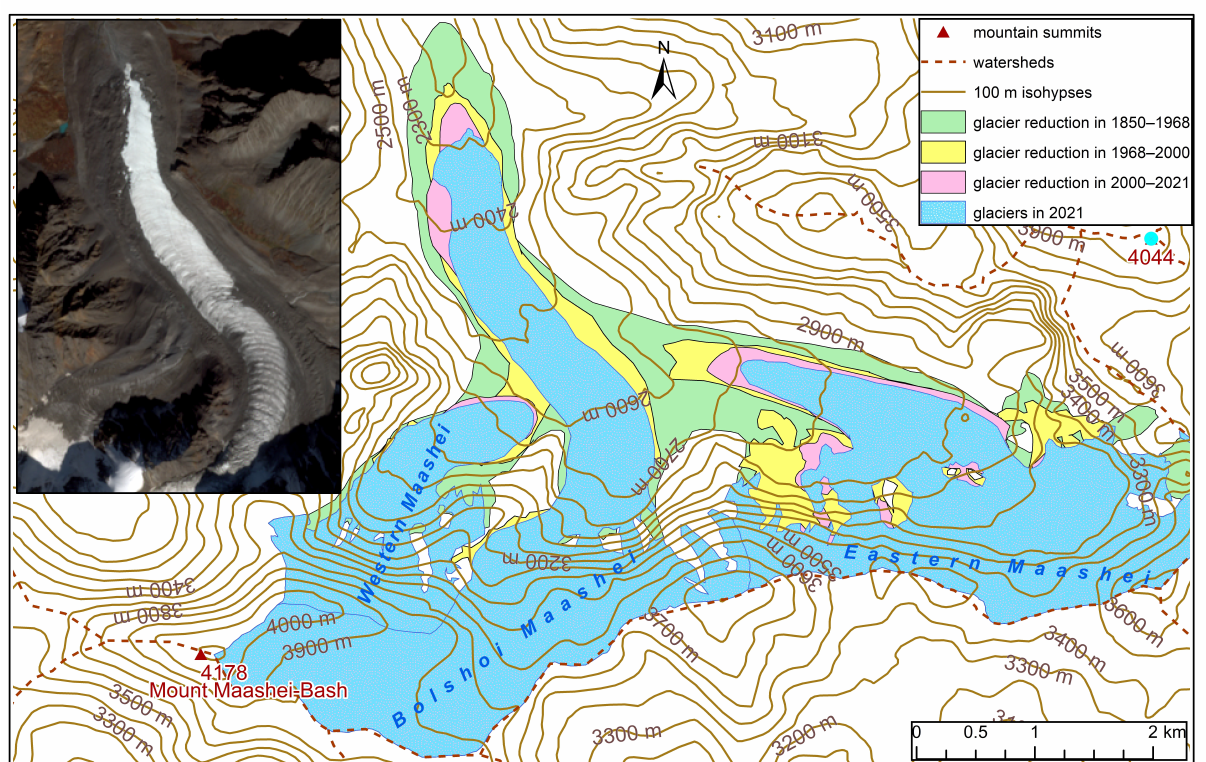
Figure 14. Shrinkage of the Bolshoi Maashei glacier system from the LIA maximum to 2021. All the altitudes were given according to SRTM-3 DEM. Left upper corner: a fragment of the Sentinel-2 image,